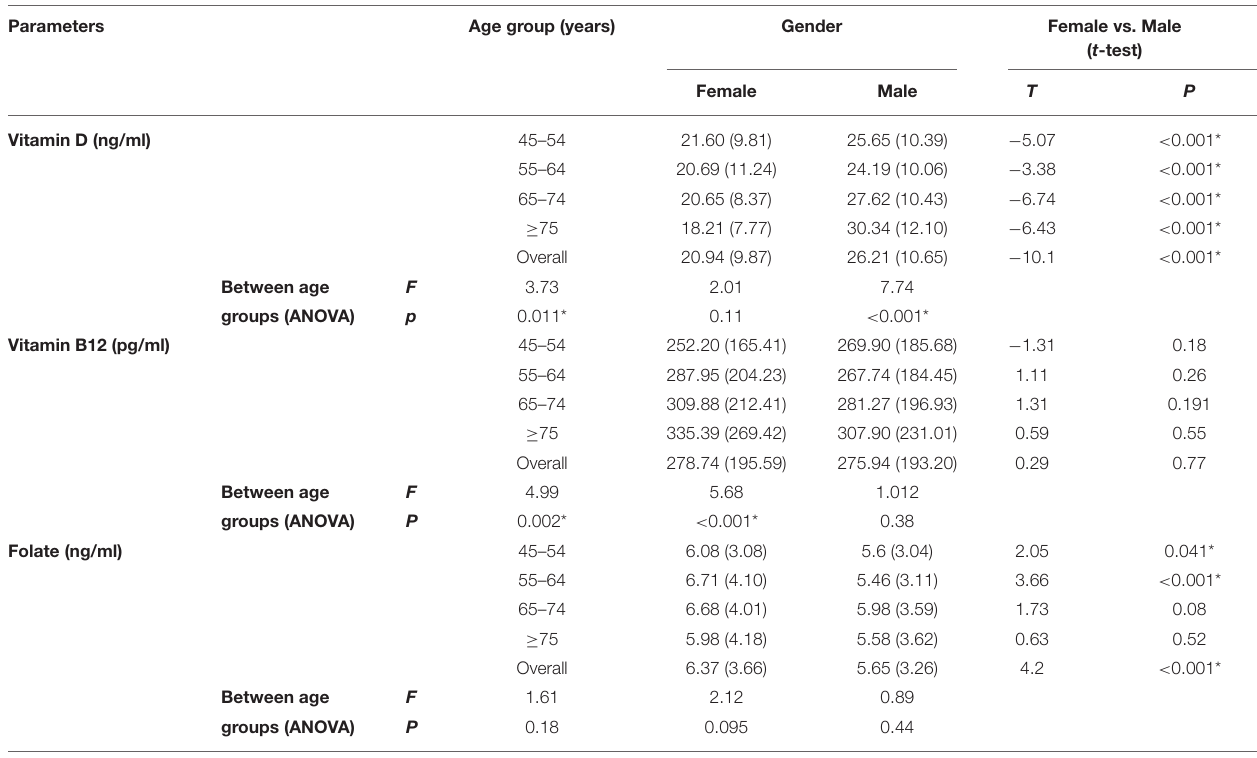
TABLE 1 | Age and gender-stratified mean levels of vitamin D, vitamin B12 and folic acid. Parameters Age group